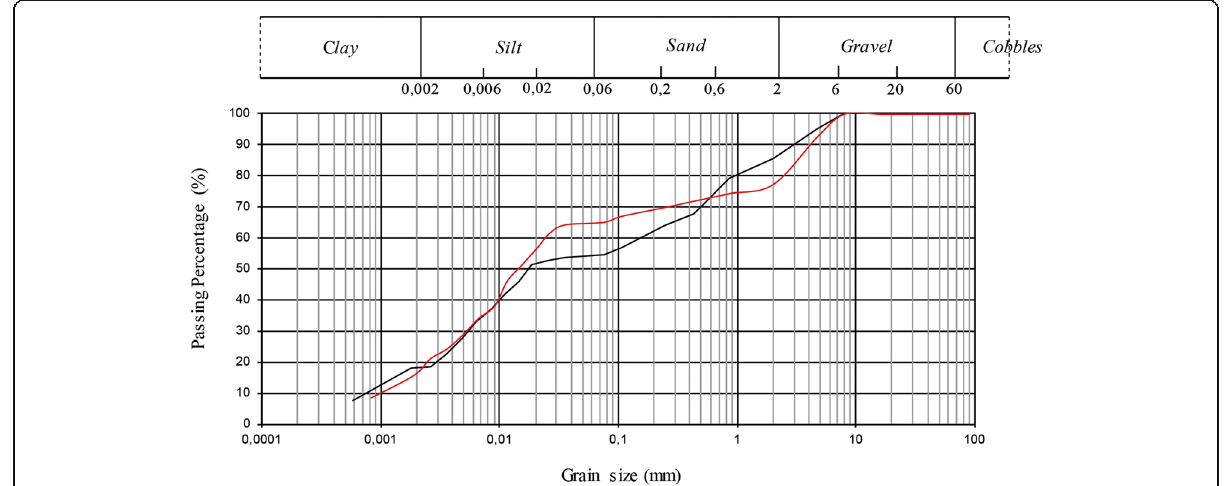
Fig. 6 Granulometric curves for the two soil samples (black line for sample and red line for sample 2)